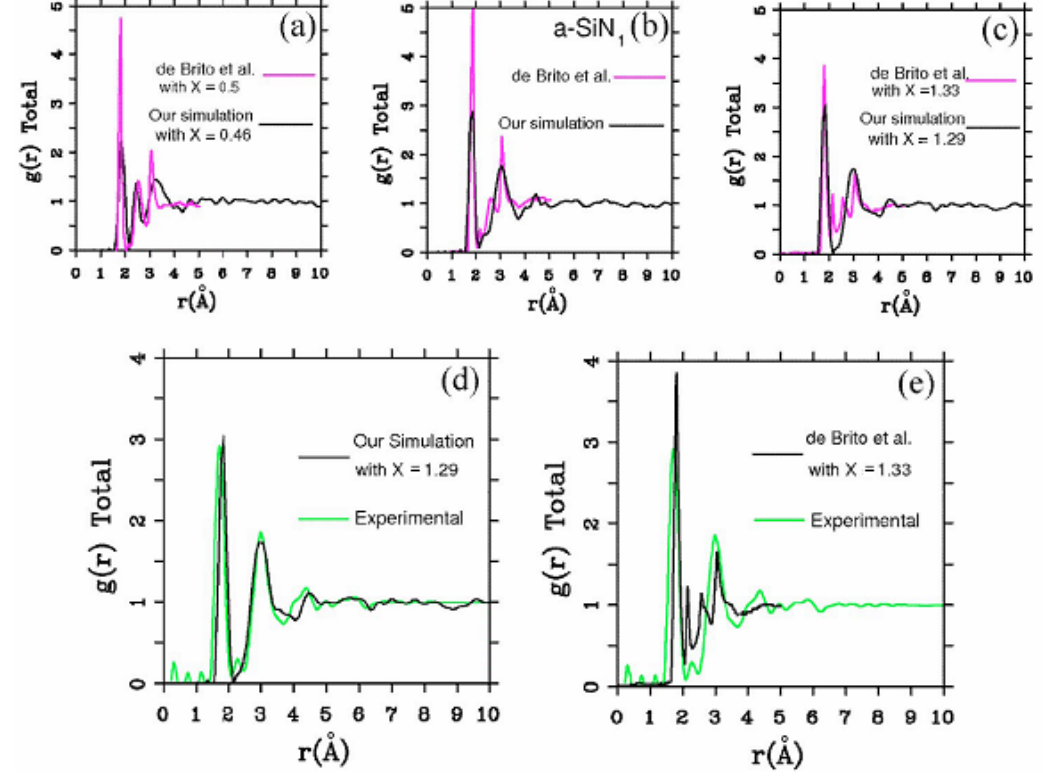
Figure 12. Comparison of our results and those obtained by De Brito Mota et al. [64-67] for the total RDF. The agreement is at best qualitative; the position of some of the peaks coincide for the samples ( a )–( c ). The experimental total RDF (green curve) is compared to our simulations, ( d ) and to de Brito Mota‘s simulations ( e ) (black